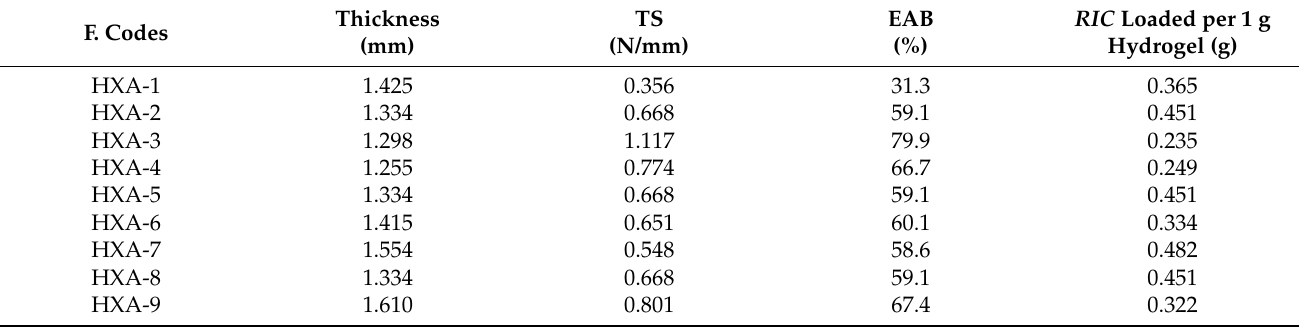
Table 3. Mechanical characteristics and drug ( RIC ) loading of